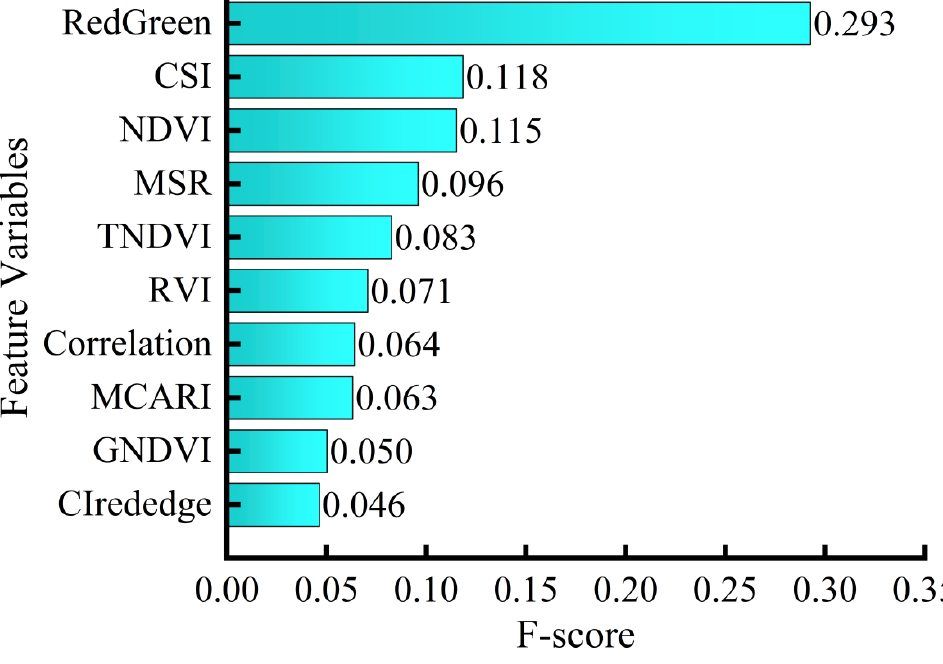
Figure 4. Importance scores of characteristic variables.